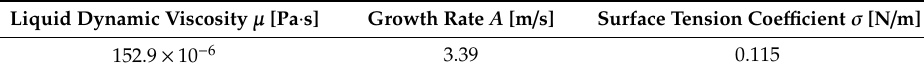
Table 3. Parameters relevant to microlayer formation: base case parameters.